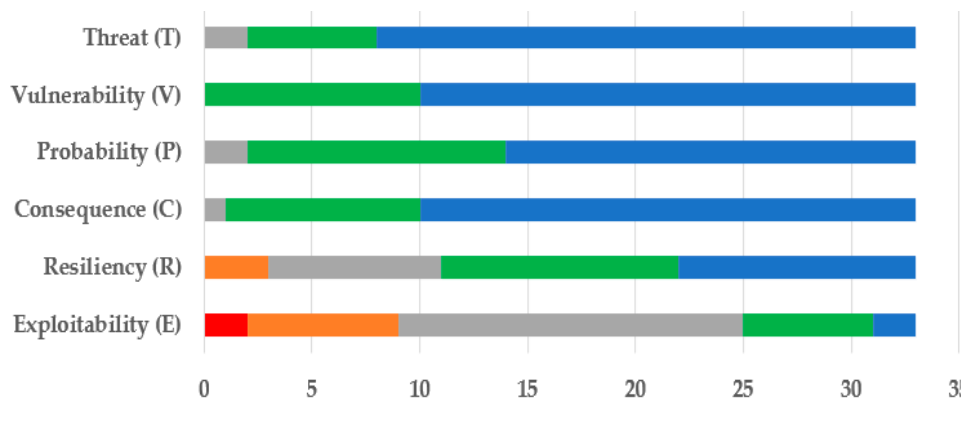
Figure 2. Experts’ attitudes on the ISRA